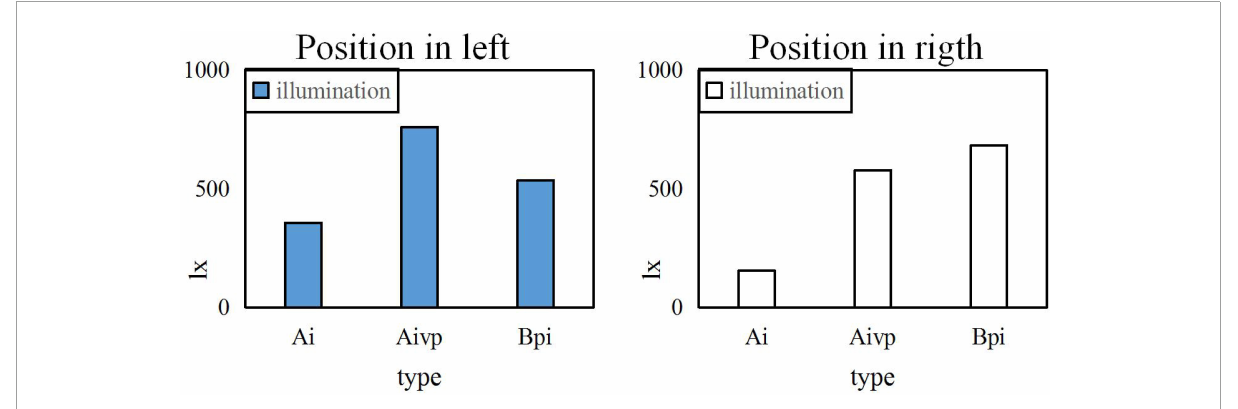
FIGURE8 Illumination comparison before and after the position when the uniformity U0 Is